Question: State the chart type depicted above.
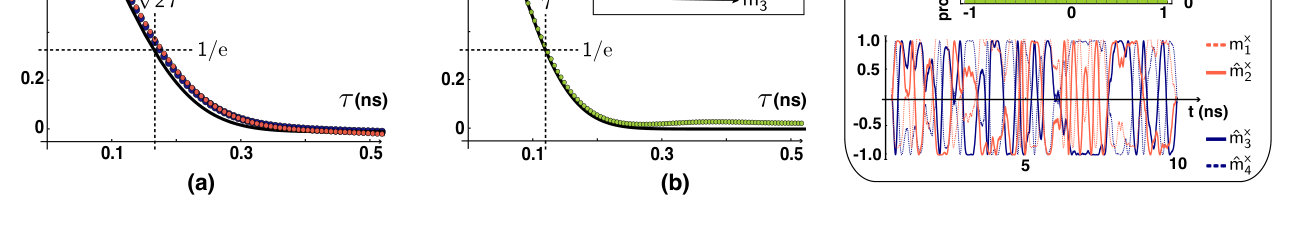
Answer: histogram